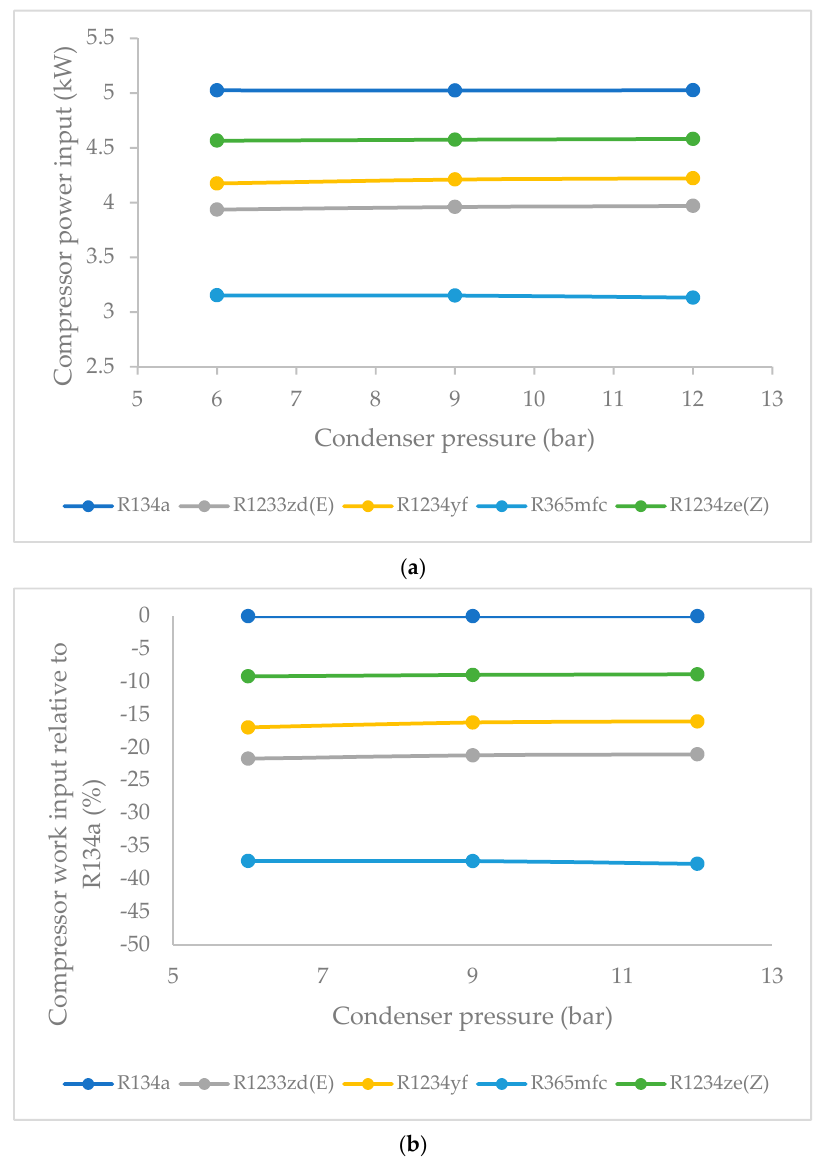
Figure 8. ( a ) Compressor work input as a function of condenser pressure (evaporator pressure = 1.5 bar). ( b ) Compressor work input relative to R134a (%) (evaporator pressure = 1.5 bar).